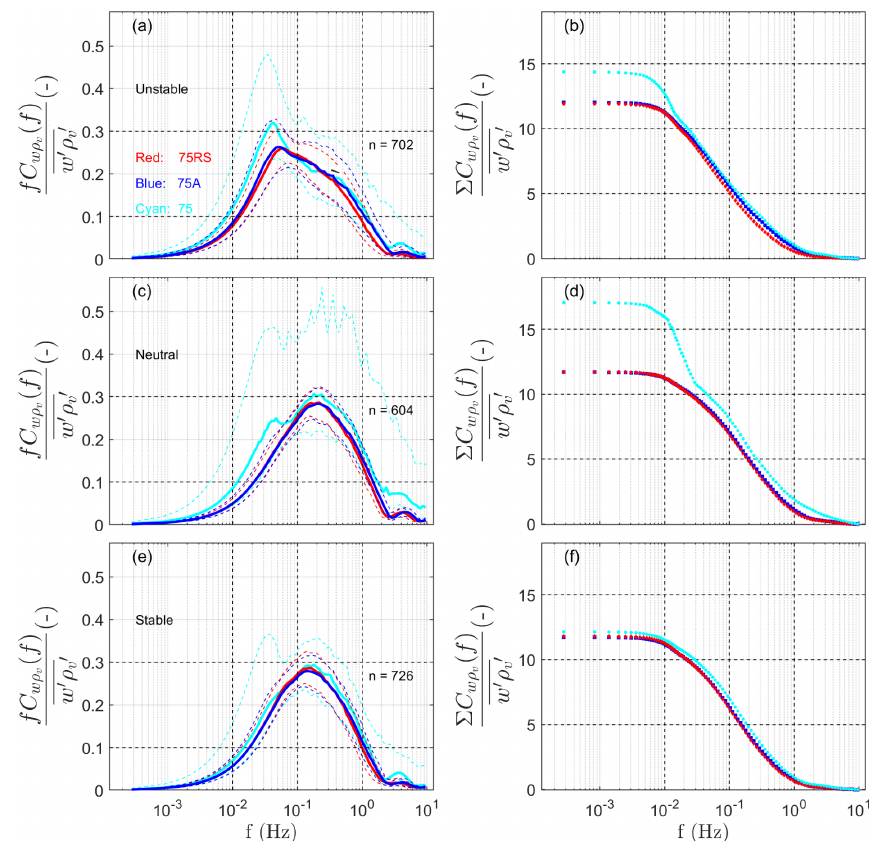
Figure 6. Ensemble median daytime (a, c, e) cospectra and corresponding (b, d, f) ogives under unstable, neutral, and stable conditions. For cospectra, the area between dotted lines shows the interquartile